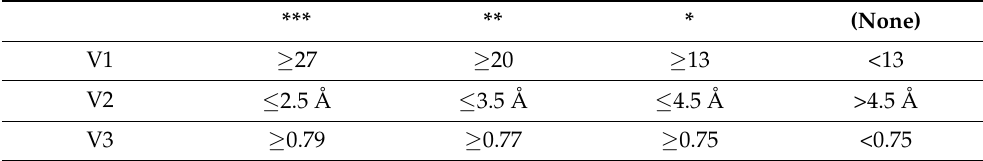
Table 4. Stars value ranges second assessment